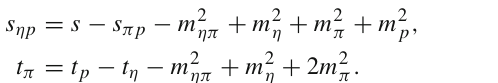
Fig. 26 ComparisonbetweentheGaussianandvonMisesdistributions for small (top) and large (bottom) phase shift uncertainties, centered in μ = 0. In the upper plot the Gaussian distribution has σ = 0 . 28 (dotted blue), and von Mises has ˆ κ = 1 /σ 2 = 12 . 82 (solid red). In the lower plot the Gaussian has σ = 1 . 69 (solid blue, one of the largest error in COMPASS datasets), von Mises has ˆ κ = 1 /σ 2 = 0 . 35 (solid red), and another von Mises has ˆ κ = 0 . 56 (solid gold) obtained by fitting to the Gaussian distribution. The grey bands hide the region outside the [− π,π ]